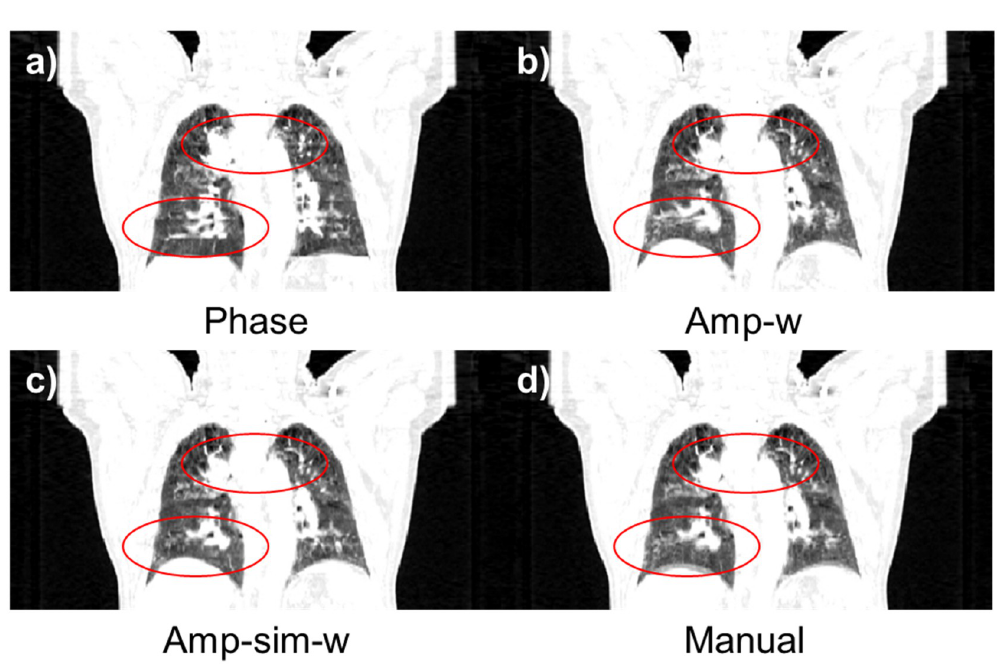
Fig 16. Coronal view of sorted 4DCT of the thoracic region according to the sorting algorithm. (Patient #16) (a) conventional phase sorting, b) amplitude-weighted phase sorting, c) amplitude-weighted phase sorting with image similarity, and d) manual sorting method.